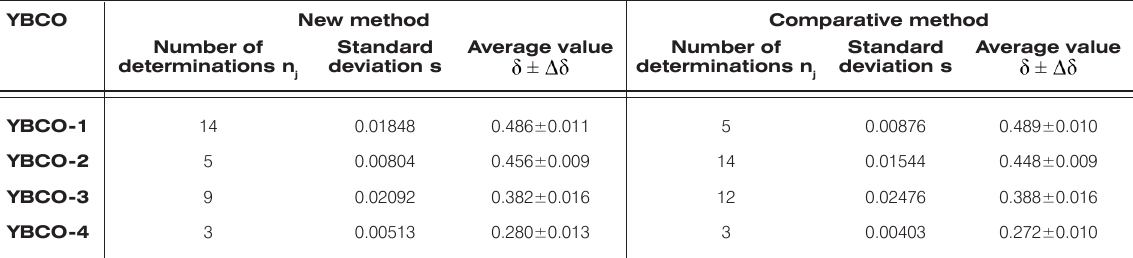
Table 3. Test of the hypothesis σ